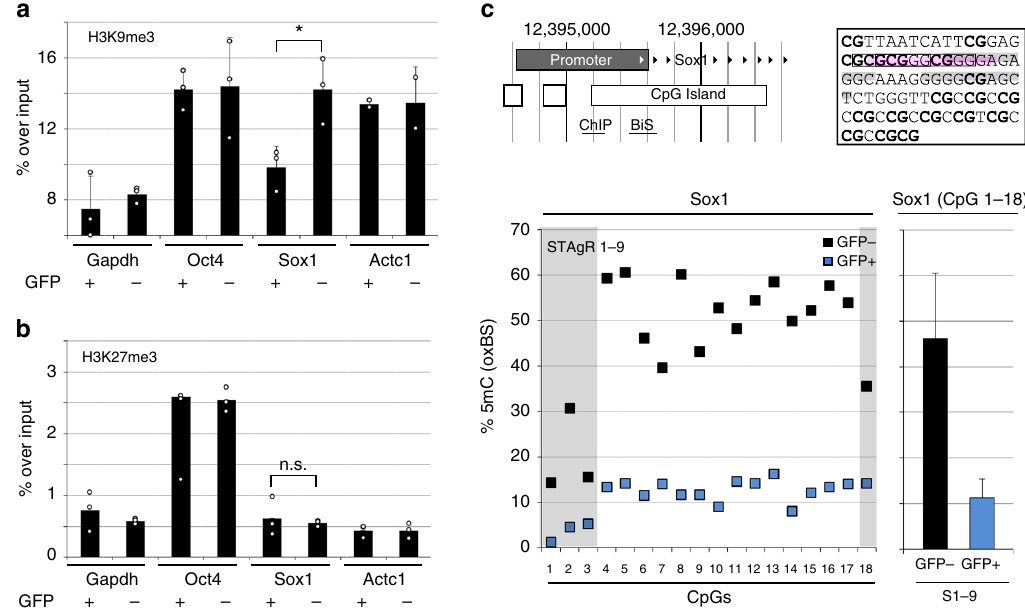
Fig. 4 Heterogeneity of chromatin marks correlates to unresponsiveness to trans-activation. a Levels of H3K9 trimethylation on the Sox1 promoter differ signi fi cantly. Sox1 GFP -positive and -negative samples were sorted to perform ChIP for H3K9me3. Gapdh , Oct4 , and Actc1 are included as controls. Levels of K9 trimethylation were signi fi cantly higher in the Sox1 GFP -negative population compared to the GFP-positive population. Data shown as mean and standard error of the mean of n = 3 biological replicates, performed on different days in different clonal lines, * p < 0.05 in two-sided Student ’ s t -test. b Levels of H3K27 trimethylation on the Sox1 promoter are similar. Sox1 GFP -positive and -negative samples were sorted to perform ChIP for H3K27me3. Gapdh , Oct4 , and Actc1 are included as controls. Levels of K27 trimethylation are not signi fi cantly different between the Sox1 GFP -negative and-positive populations. Data shown as the mean and standard error of the mean of n = 3 technical replicates; n.s., not signi fi cant in two-sided Student ’ s t -test. c Sox1 GFP -positive NPCs exhibit lower DNA methylation at the Sox1 promoter. (Top left) Structure of the Sox1 promoter, locations of ChIP qPCR and BS and OxBS amplicons are shown. (Top right) Sequence of the oxBS and BS analyzed sequence in the Sox1 promoter. CpGs are marked in bold. Predicted binding sites of YY1 (marked in grey) and Sp1/Sp3 (marked in pink) as well as E2F-1 (boxed) are indicated. (Below). Sox1 GFP -positive and -negative cells were sorted to perform oxidative bisul fi te sequencing. This revealed elevated DNA methylation levels in non-responsive cells on the Sox1 promoter (data depict the mean and standard error of the mean of NGS reads of at least n = 1000 individual sequences generated from two individual biological replicates generated